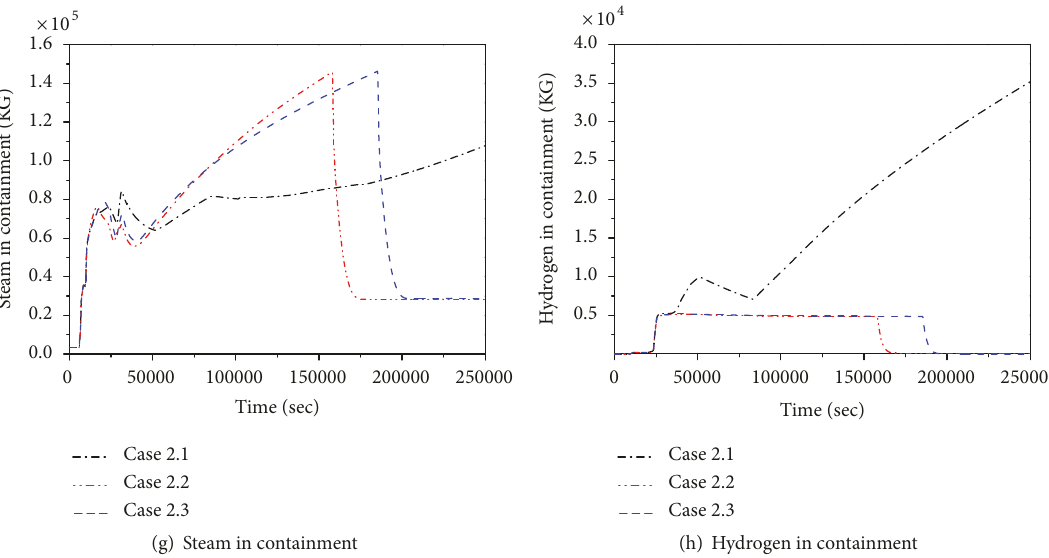
Figure 8: Effect of cavity injection timing.